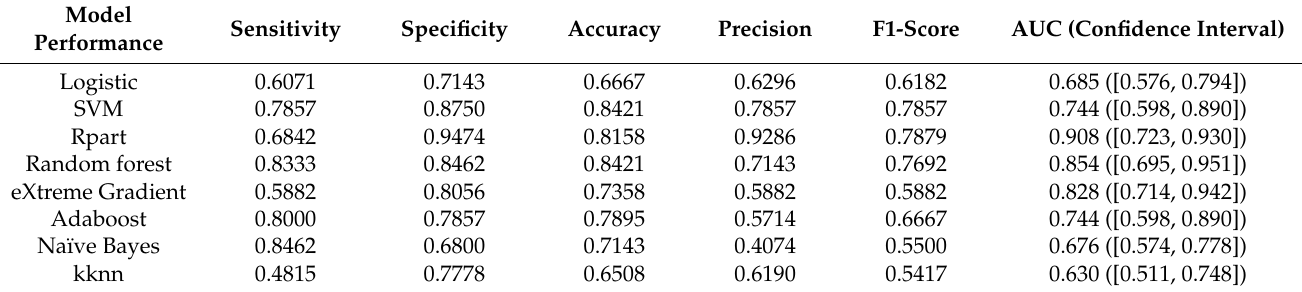
Table 2 summarizes the values of the eight algorithms. Table 2. Performance of eight machine learning algorithms with six measuring